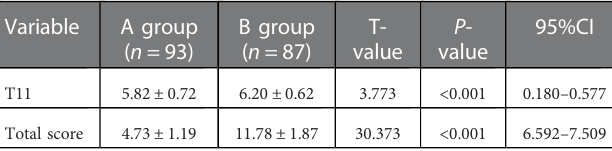
TABLE 4 Comparison of the time (h) required for urination of more than 100 ml after anesthesia and international prostate symptom